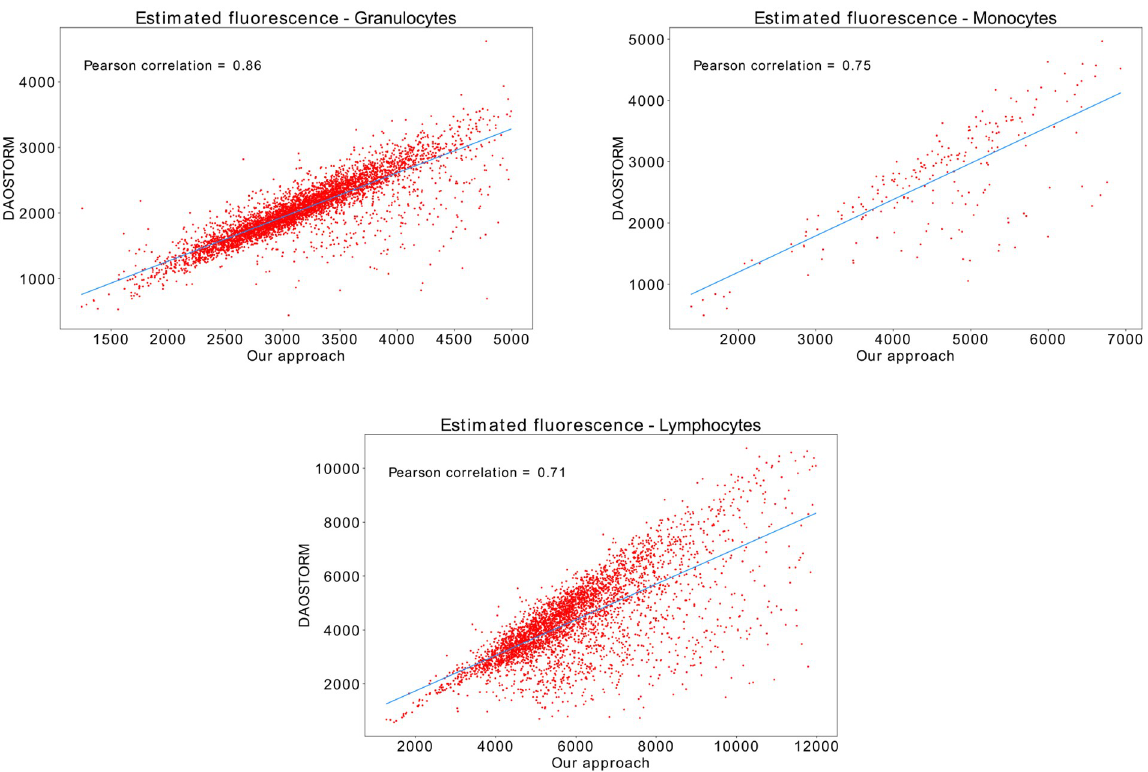
Fig 4. Photometry comparisons. Scatter plots showing the correlation between our approach and DAOSTORM for granulocyte, monocyte, and lymphocyte populations. The blue lines in the plots represent the linear fit of the two